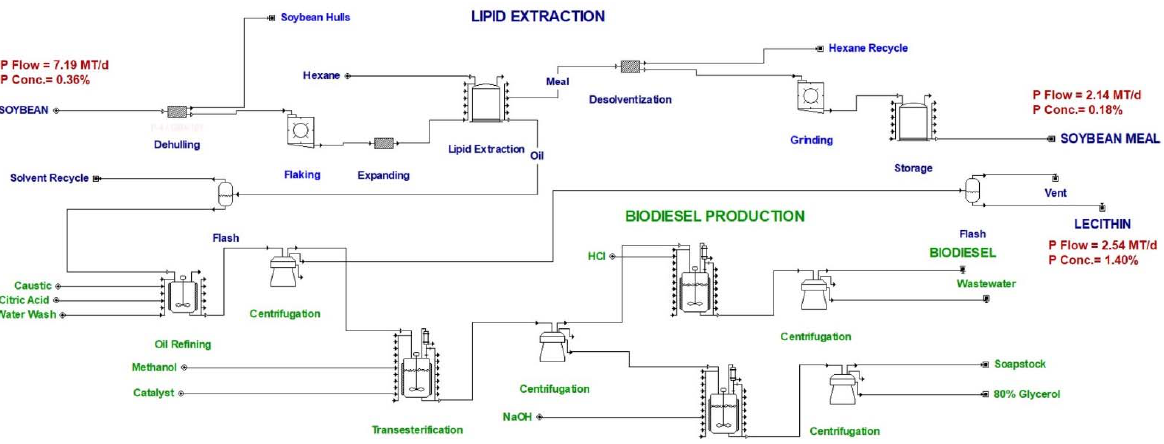
Figure 4. Schematic representation and P flows in the soybean biodiesel (SBL) process with a lecithin coproduct.